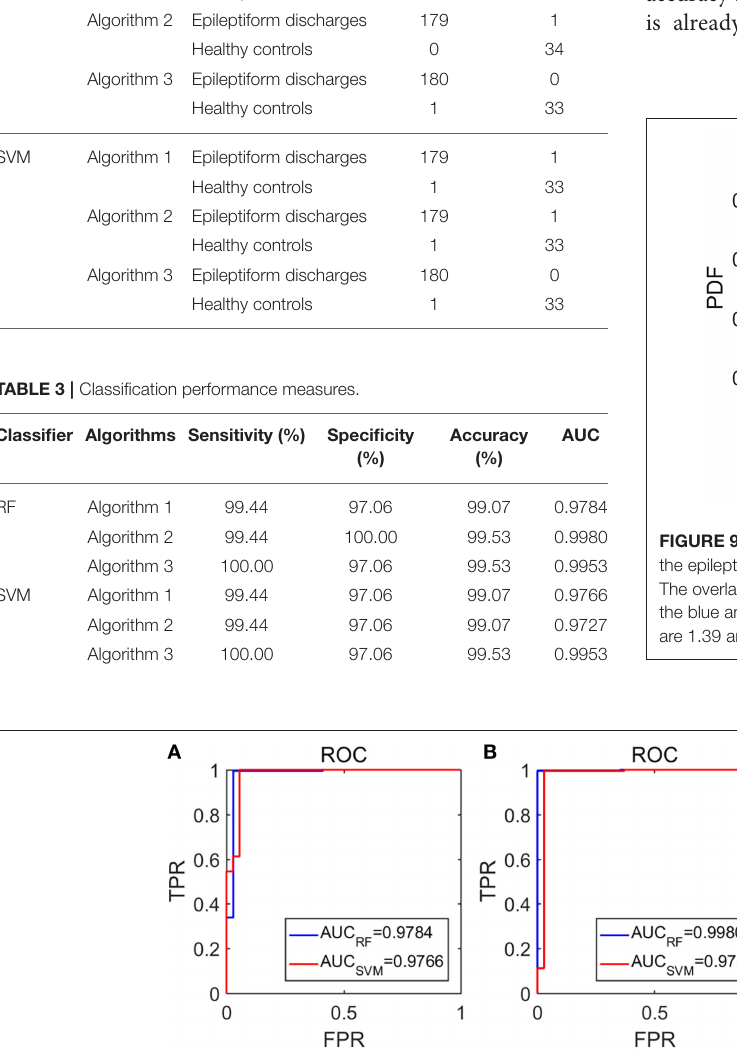
FIGURE 8 | The ROC curves for the testing data: (A–C) are for algorithms using PSD and λ ( ǫ 1 ), PSD and λ ( ǫ 2 ), and PSD and λ ( ǫ ), respectively.